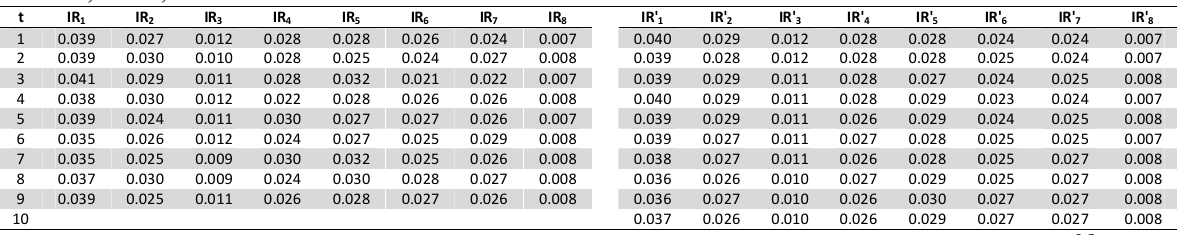
serves as the measure of future uncertainty, is provided for each IR (Raharjo & Brombacher, 2011). Actual, fitted, forecasted values of all IR